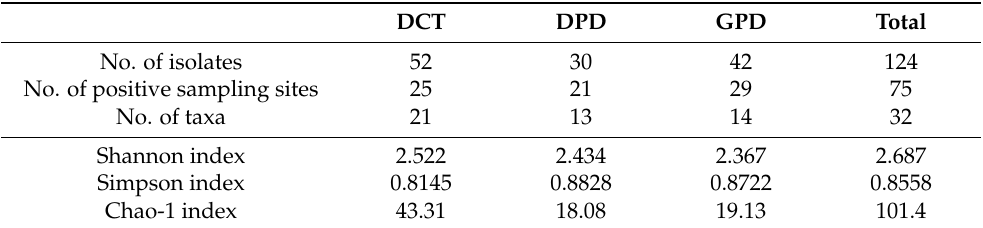
Table 2. Isolate data and diversity indices summary for the three investigated sites: diesel car tank (DCT), diesel pump dispensers (DPD), and gasoline pump dispensers (GPD). DCT DPD GPD Total No. of